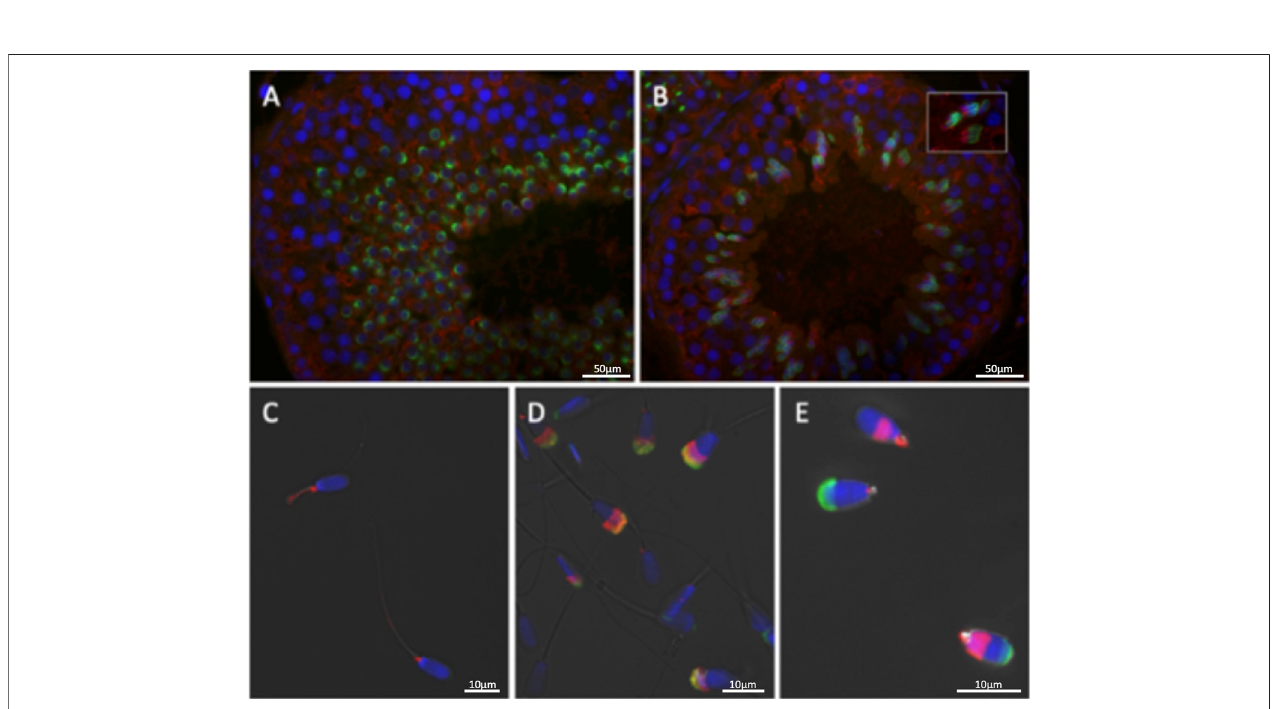
FIGURE4 | Thedistribution ofEML5-related protein EML4 (red) in spermatozoa and testicular tissues is restricted to the cytoplasmic lobe ofround spermatids (A) and the caudal manchette of elongating spermatids (B) . (C – E) Sperm EML4 distribution is altered by EML5 genotype and sperm phenotype: Connecting piece and midpiece localization is prevalent in bulls with overall good sperm morphology (C) , while subacrosomal/acrosomal localization was found in the homozygous EML5 mutant bull (D) and post-acrosomal sheath localization is prominent in an infertile asthenoteratozoospermic sire with 100% stump-tails (E) .